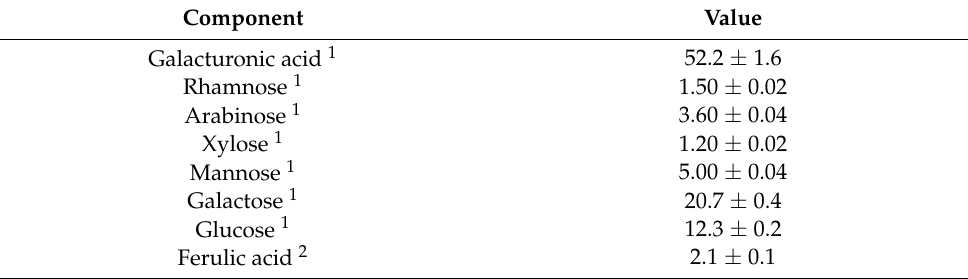
Table 1. Chemical composition of sugar beet solid waste (SBWP).